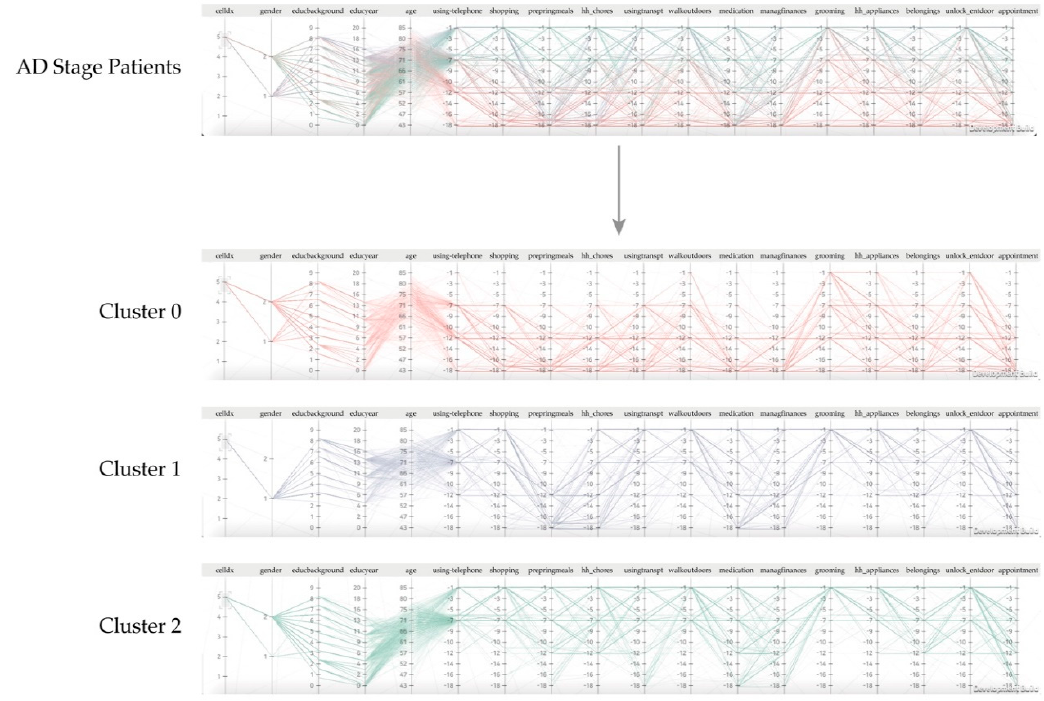
Figure 8. The result of AD stage segmentation using the Parallel Coordinates graph.